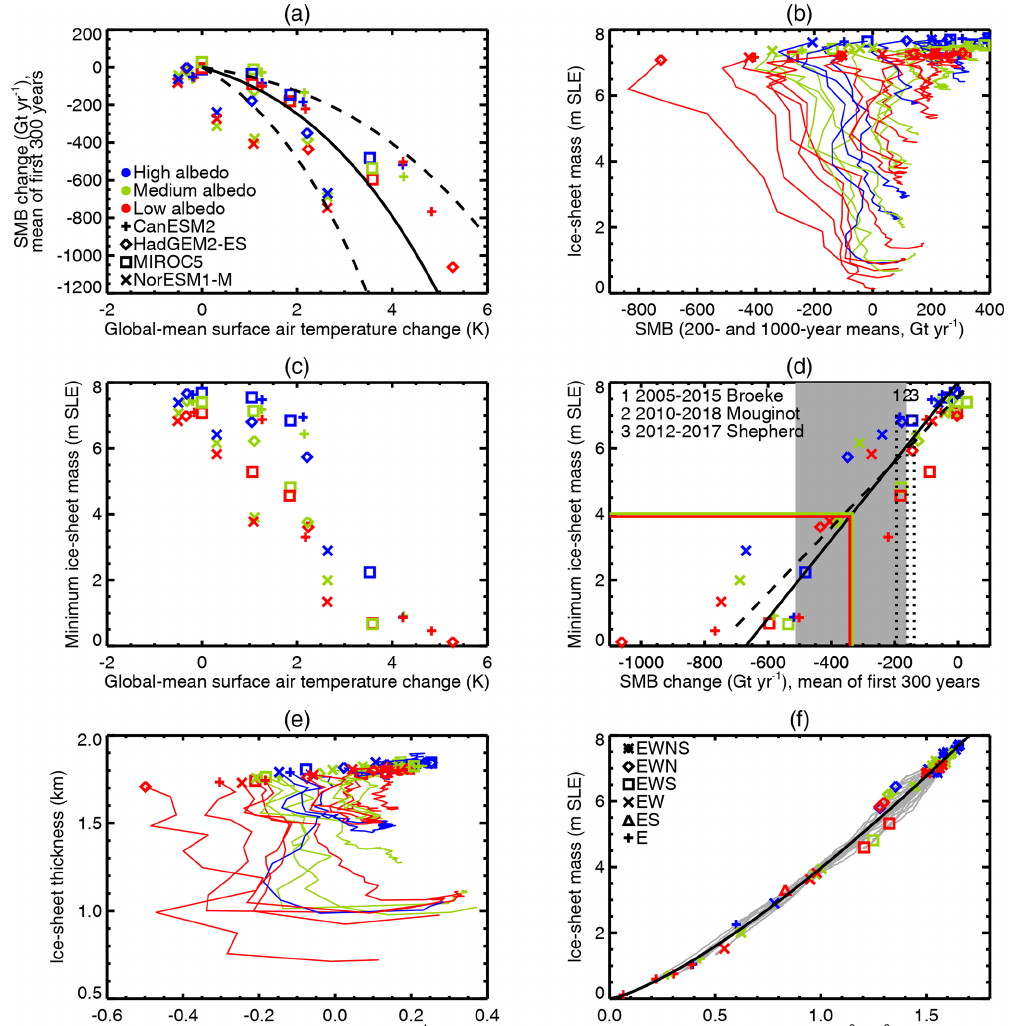
Figure 2. Relationships between various quantities in the first set of experiments, with FiG under constant climates listed in Table 2 and run to a steady state, as shown in Fig. 4b. All panels use the key of (a) for colours; (b) – (e) use the key of (a) for symbols. (a) Time mean (cid:49) SMB vs. (cid:49) SAT, both for the first 300 years relative to the initial steady state under the historical MIROC5 climate with the same albedo parameter. The solid curve is the cubic relationship fitted by Fettweis et al. (2013) to MAR projections, and the dashed curves delimit the likely range of the AR5. (b) Trajectories of ice sheet SMB (not (cid:49) SMB) vs. mass M , shown as 200-year means for the first millennium and 1000-year means thereafter. The trajectories begin at the symbols, with M close to the observed for the present day and a wide range of SMB. They end with a wide range of M but all have positive SMB. (c) Final steady-state M vs. time mean (cid:49) SAT in FAMOUS–ice for the first 300 years. (d) Final steady-state M of the ice sheet vs. time mean (cid:49) SMB of the first 300 years. The vertical dashed lines mark the observational estimates of (cid:49) SMB for the recent periods and studies shown in the key (van den Broeke et al., 2016; Mouginot et al., 2019; Shepherd et al., 2020); for van den Broeke et al. (2016) we used the steady-state SMB for 1961–1990 and the SMB trend for 1991–2015. The oblique solid and dashed lines are linear regressions of M vs. (cid:49) SMB and vice versa, respectively, for (cid:49) SMB > − 700 Gtyr − 1 . The solid horizontal lines indicate the threshold of irreversibility for medium and low albedo, and the solid vertical lines translate them into (cid:49) SMB thresholds, with uncertainty ( ± 2 standard deviations) shown by the grey band. (e) Trajectories of ice sheet thickness (volume divided by area) vs. specific SMB for 1000-year means, beginning at the symbols. (f) Trajectories of M vs. ice sheet area as grey lines, with the final configurations indicated by the symbols and the fitted power-law relationship shown by the black